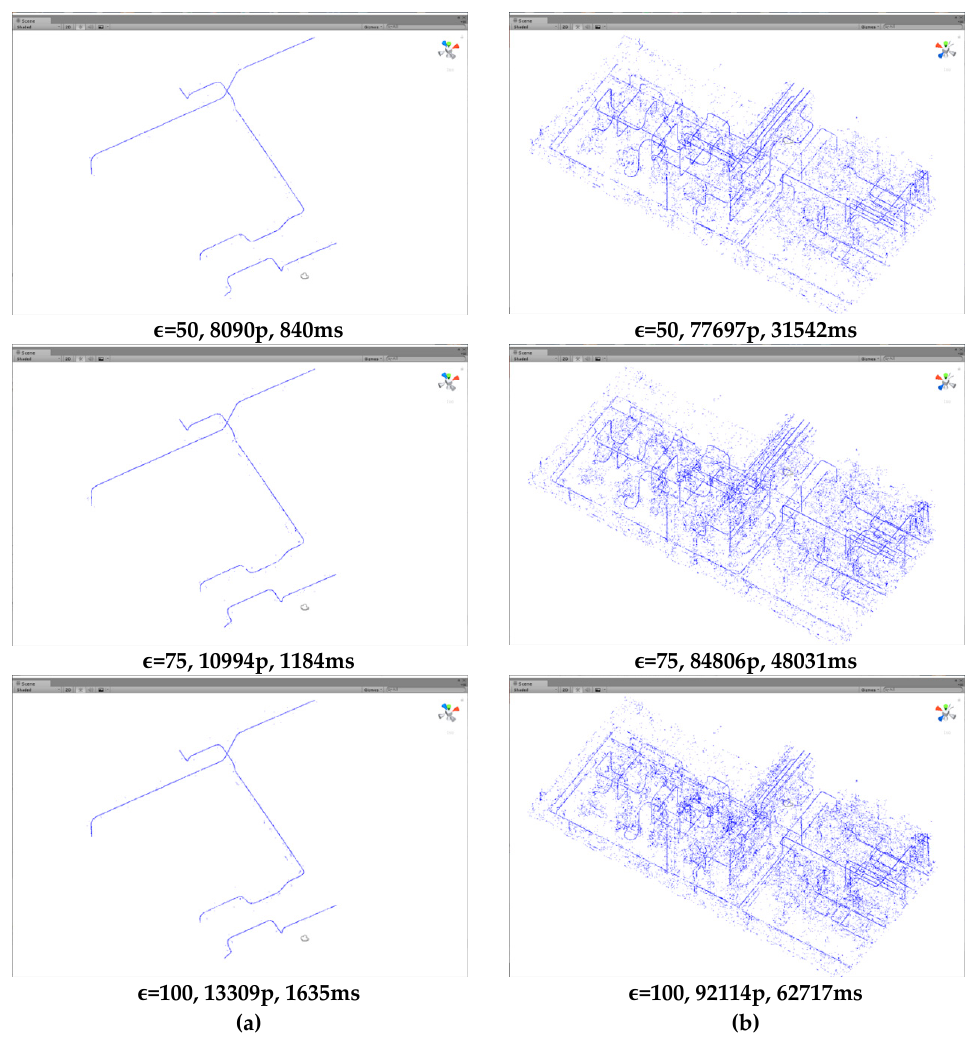
Figure 5. Matching execution time and results according to matching increase value: ( a ) segmented data, ( b ) full data.